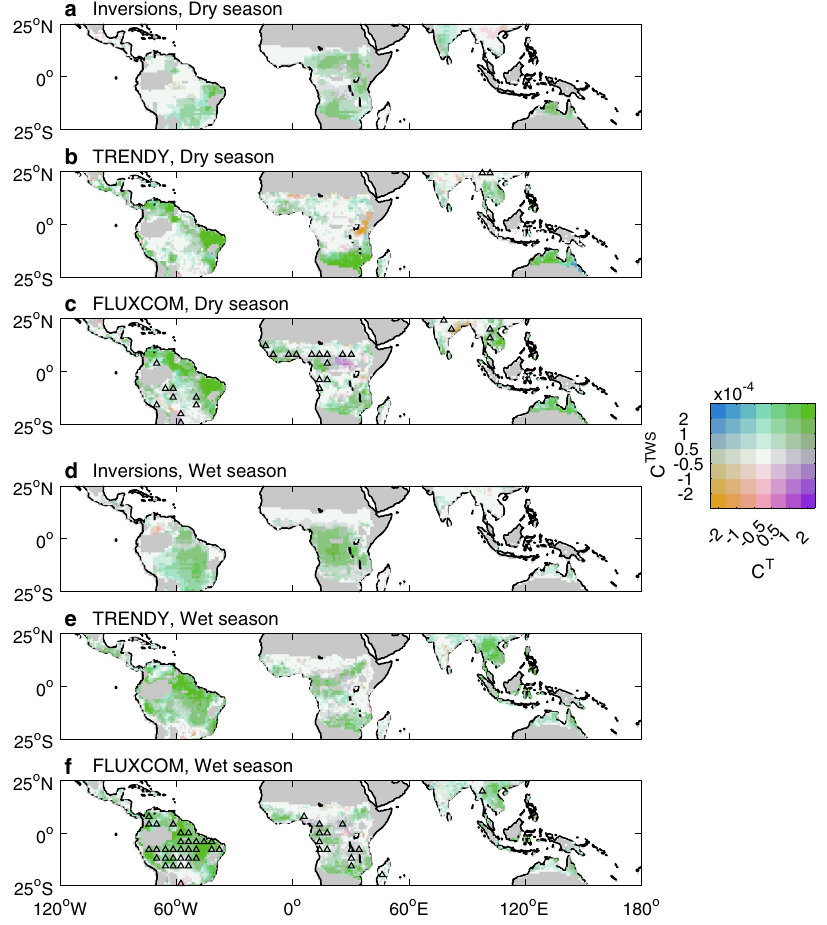
Fig. 5 Spatial distribution of the C TWS and C T in the tropics during the dry and wet seasons. C TWS and C T indicate contributions to the global correlations of interannual variability of net ecosystem exchange (NEE IAV ) against terrestrial water storage and temperature, respectively. NEE IAV is estimated by atmospheric inversions ( a , d ), DGVMs from the TRENDY project in simulation S2 (NEE output) ( b , e ), and FLUXCOM models ( c , f ). Note that pixels where there is only a dry or only a wet season within a year are excluded. Triangles indicate that using simulated soil moisture by DGVMs or water availability index (WAI) for FLUXCOM models as terrestrial water storage instead of using observation-based terrestrial water storage would change the sign of C TWS